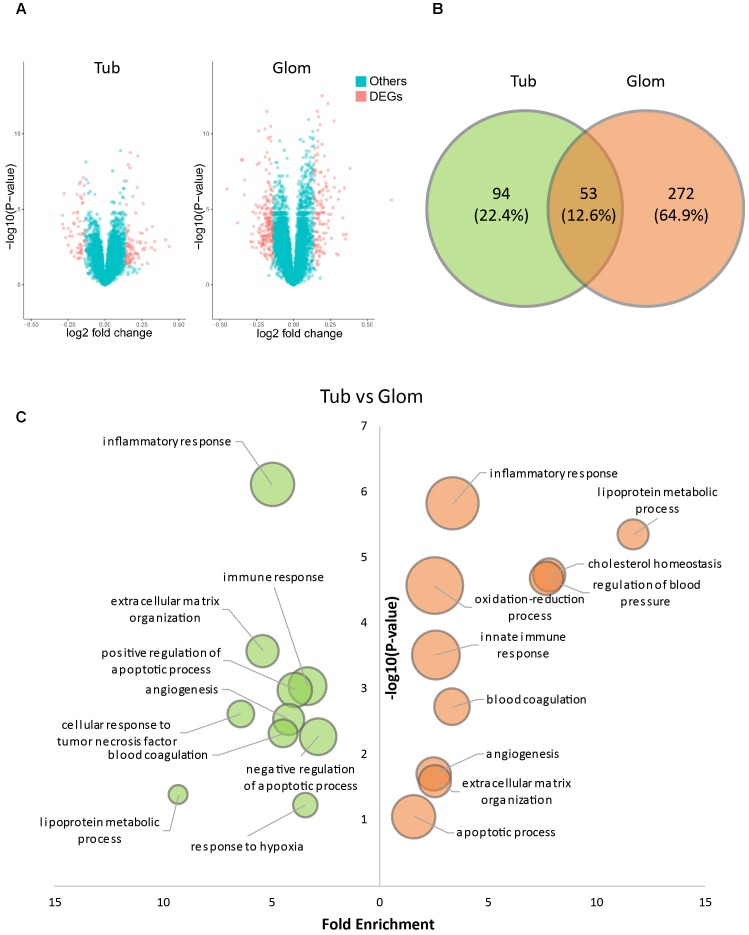
Differentially expressed genes (DEGs) in tubules and glomeruli of HN patients. (A) Volcano plot of differentially expressed genes in tubules and glomeruli. (B) Venn diagram of DEGs in tubules (green) and glomeruli (orange). (C) Bubble plot of enriched GO terms of DEGs of tubules (green) and glomeruli (orange). X-axis is fold enrichment, Y-axis is related with p-value of enrichment analysis. Bubble size changes with the count of targets in this term.